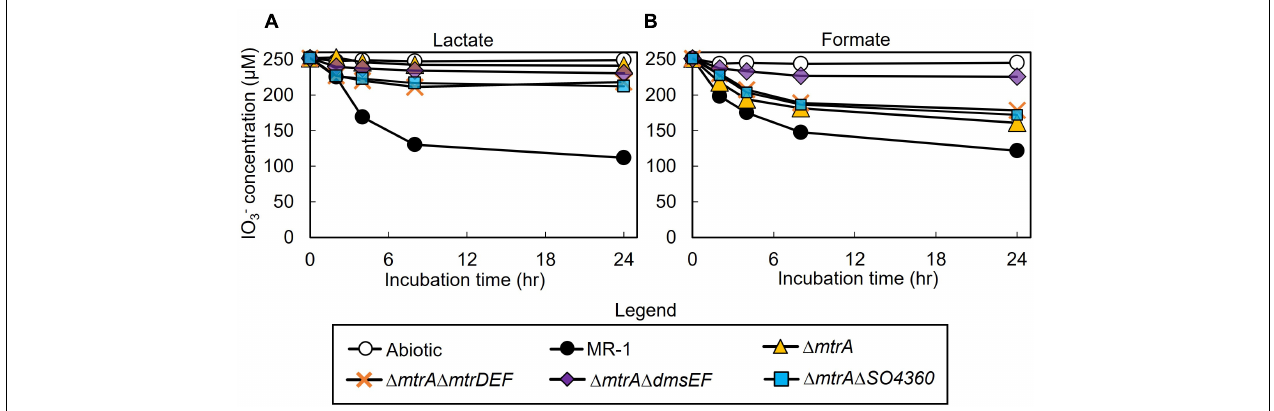
− as the electron acceptor and lactate (A) or formate (B) as the electron donor and their IO 3 anaerobic incubations. Error bars represent one standard